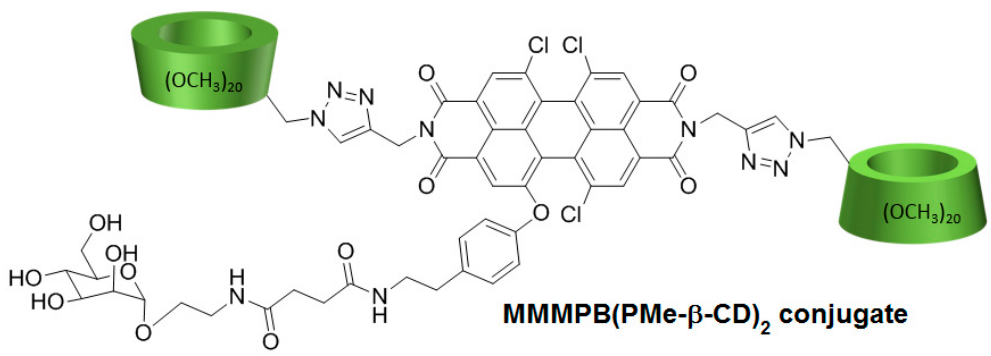
Figure 34. Chemical structure of mono-mannose modified perylene bisimide (MMMPB)/(PMe- β -CD) 2 conjugate.